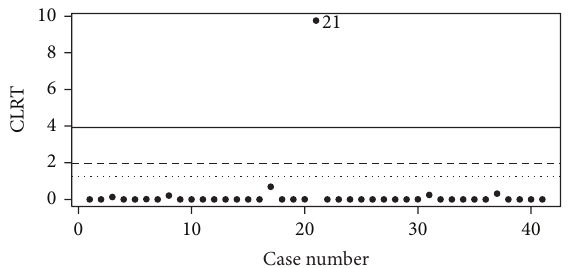
Figure 5: Score test statistic for each case, with 95th percentile of the empirical distribution under 𝐻 0 shown for the first 𝑘 order statistics for score test: 𝑘 = 1 (solid line), 𝑘 = 2 (dashed line), and 𝑘 = 3 (dotted line).